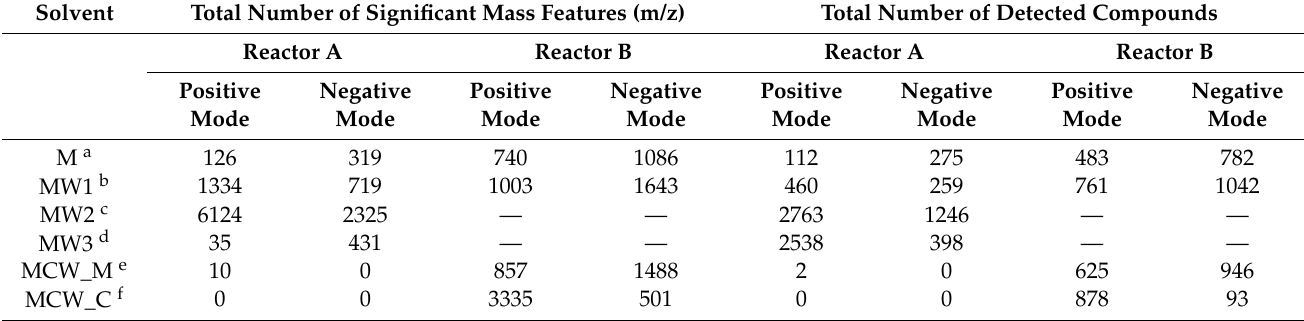
Table 3. Number of significant per-mass feature ANOVA tests between experimental stages * within each solvent group (at an FDR <